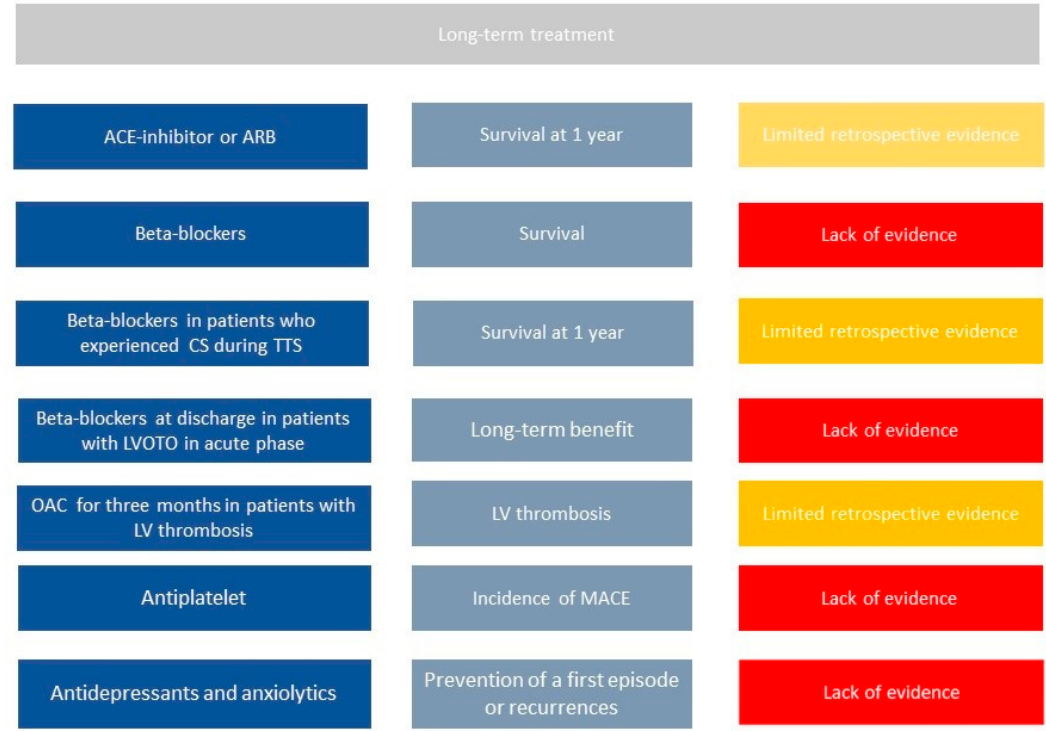
Figure 2. Current literature on long-term management of Takotsubo syndrome patients. First column shows all potential drugs in TTS patients, second one potential benefits, third one current evidence in literature. Legend: CS = cardiogenic shock, LV = left ventricle, LVOTO = left outflow tract obstruction, MACE= mayor cardiac events, OAC = oral anticoagulation, TTS = takotsubo